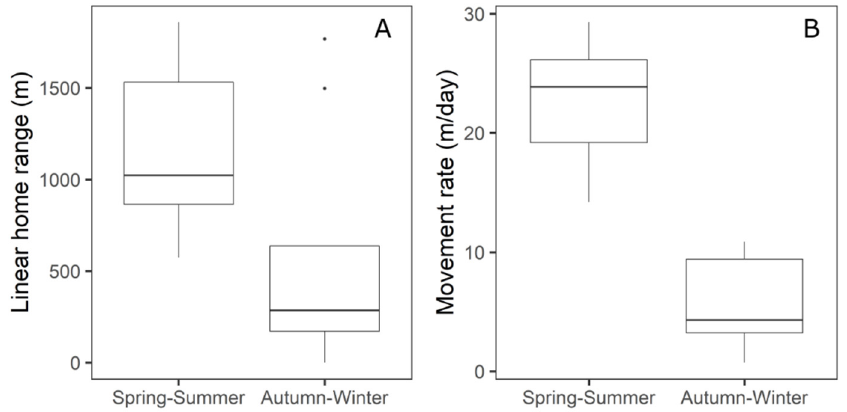
Figure 3. ( A ) Linear home range of tagged Wels catfish during spring–summer and autumn–winter ( n = 9). ( B ) Average individual rate of movement during spring–summer and autumn–winter ( n = 9).